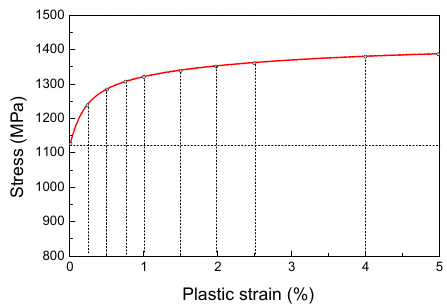
Figure 1. Curves of stress versus plastic strain.